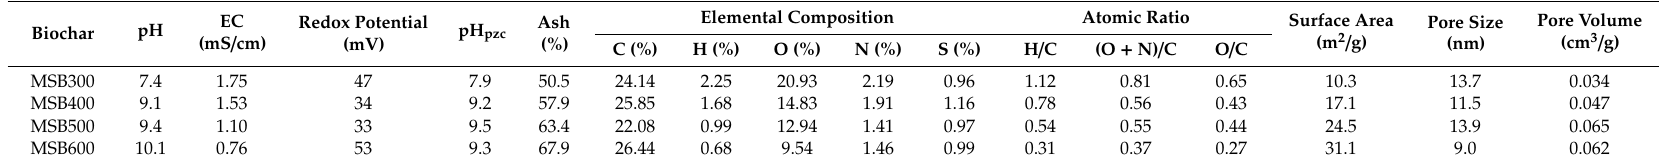
Table 1. Physio-chemical properties of maize straw biochars (MSB) pyrolyzed at 300, 400, 500, and 600 ◦